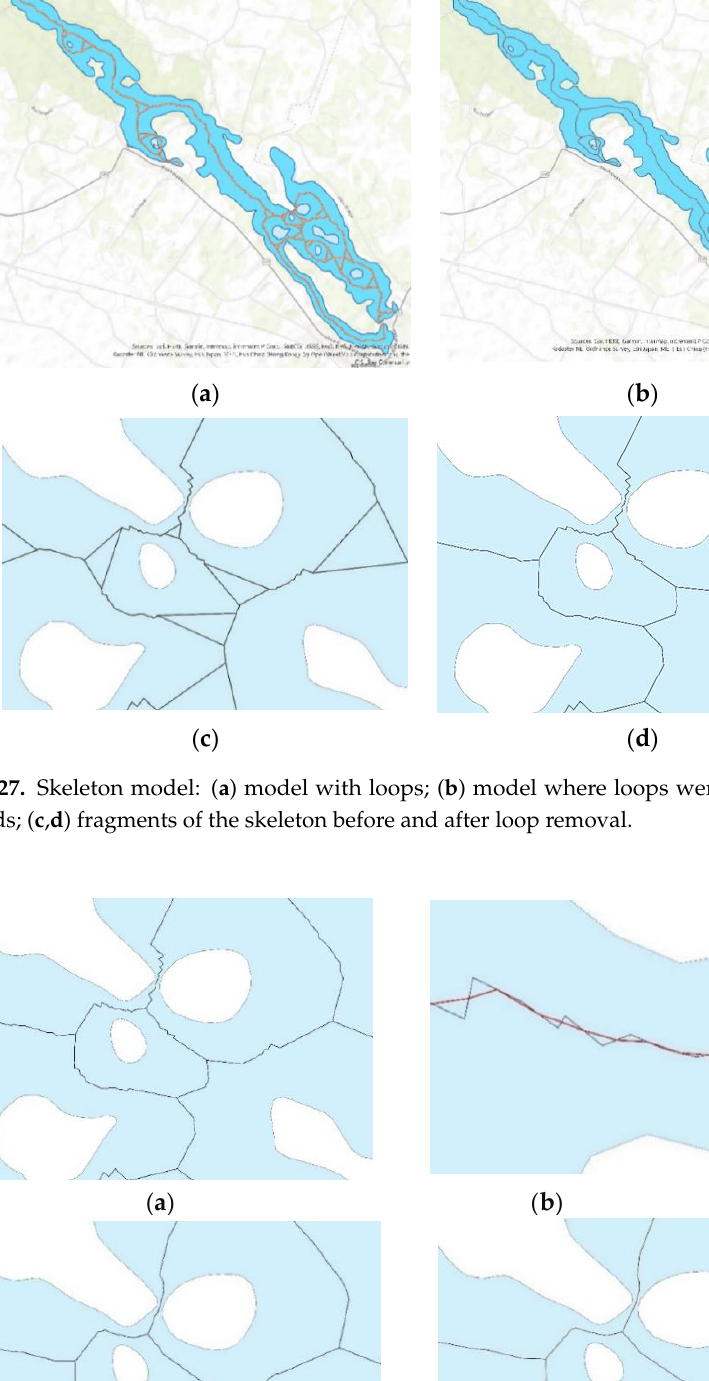
Figure 29. A model of the network skeleton generated in a geometrically complex polygon representing Lake Wydmińskie based on the adopted set of base points, after loop elimination and two iterations of the smoothing procedure to remove zigzag effects. In successive iterations of the smoothing process, the location of the resulting object should be controlled inside the polygon.